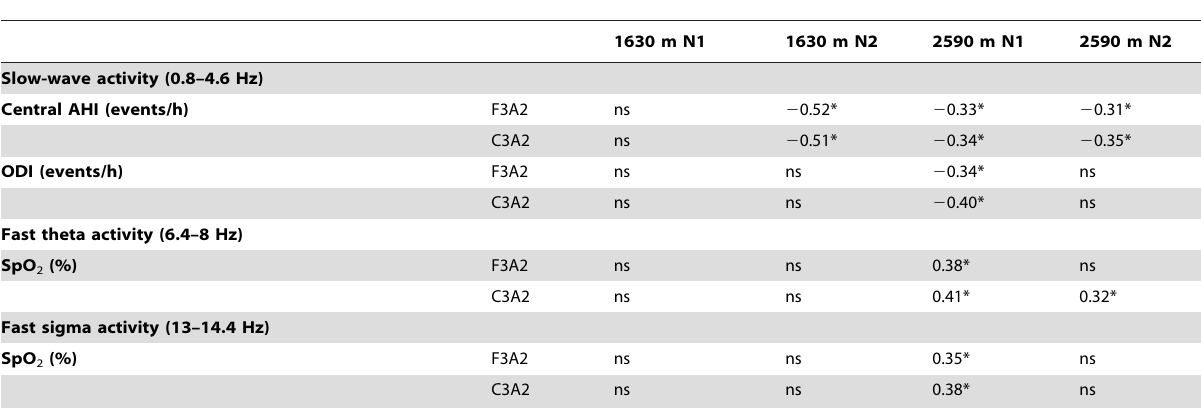
Table 3. Correlations between spectral power and breathing variables.